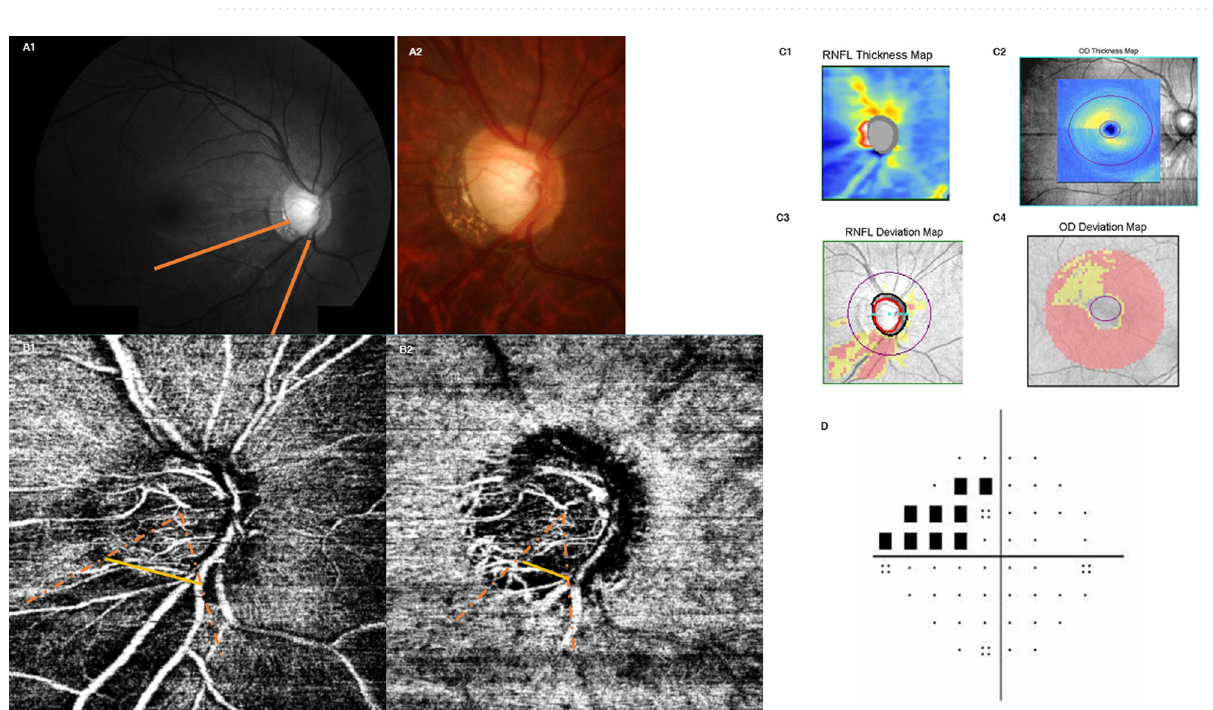
Figure 4. A Representative case of wider localized vessel density defect on the superficial layer. A 45-year-old man had a retinal nerve fiber layer defect at inferotemporal area ( A , C ) and correspondent visual field defect was observed at superior ( D ). The image of optical coherence tomography angiography had a good signal strength index, 65, and the measured widths of the vessel density defect were 79.6° for the superficial layer and 58.9° for the deep